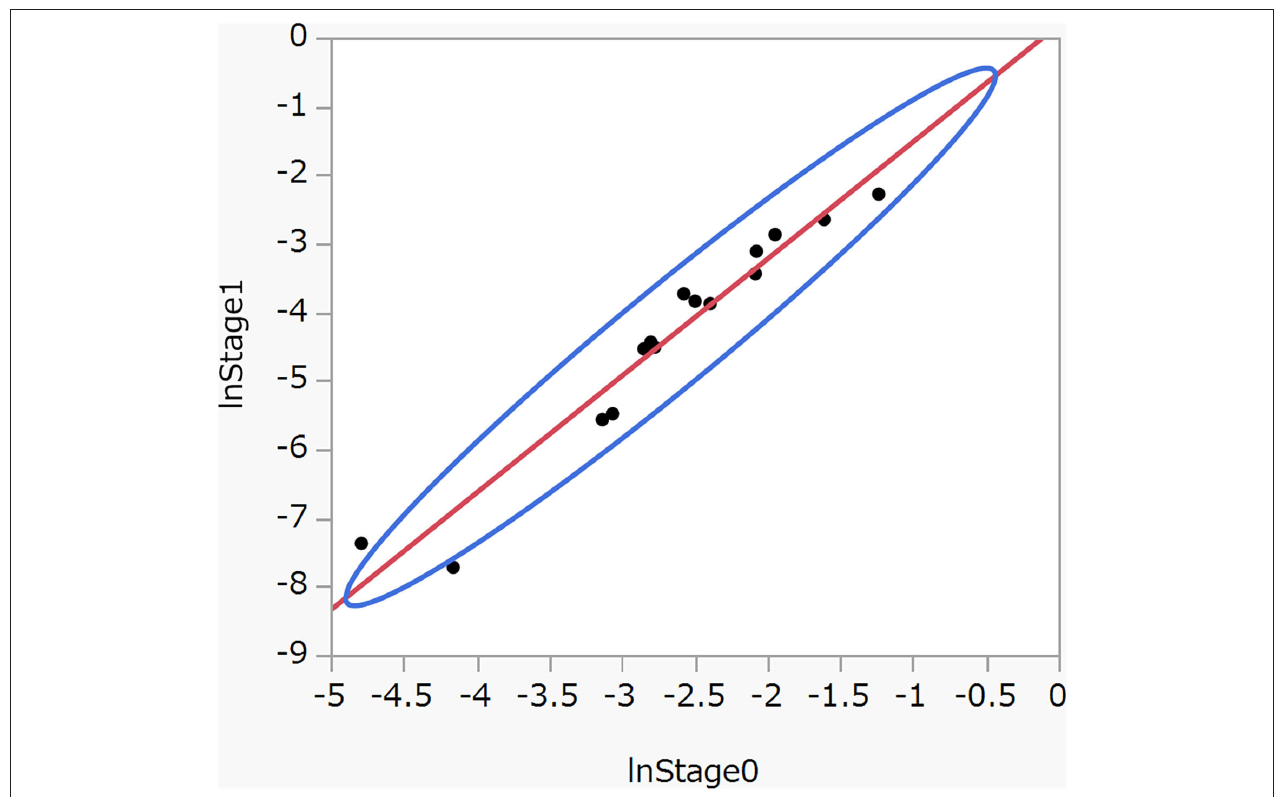
FIGURE 2 | Scatter plot between log (severe rate) in stage 0 and stage 1 with 95% density ellipse.